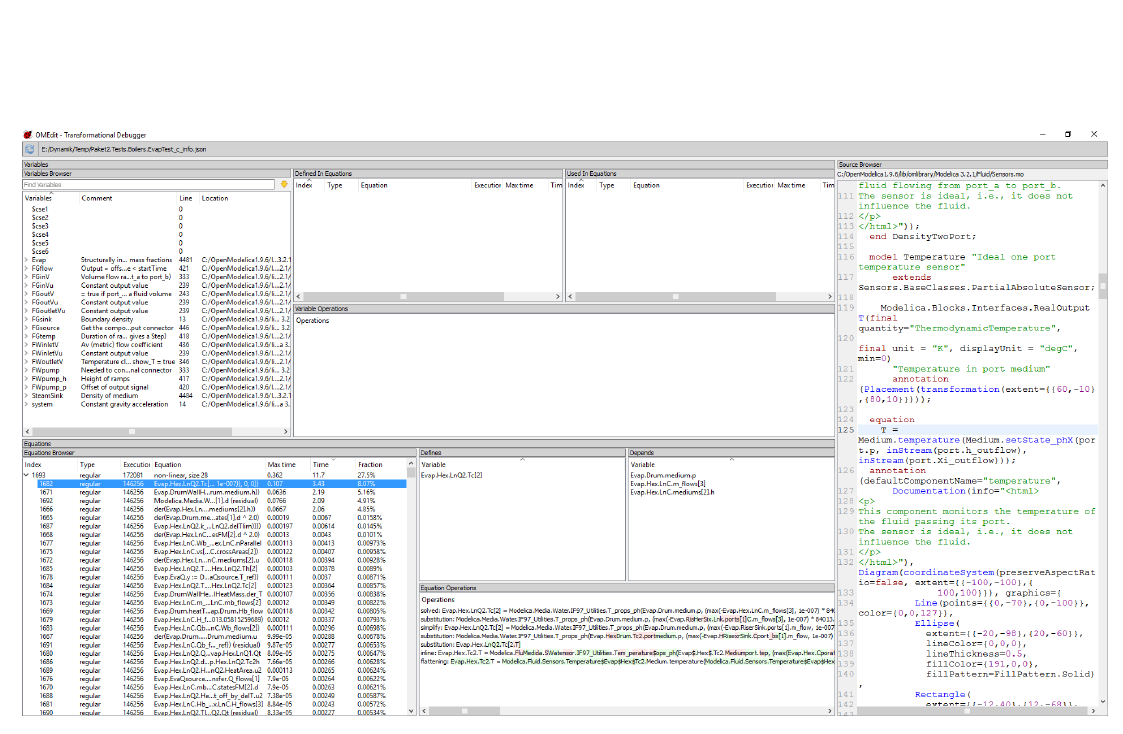
Figure 12: Using the performance pro(cid:28)ler to (cid:28)nd the computationally heaviest equation after sorting according to used time (table lower left), see close-up in Figure 13.